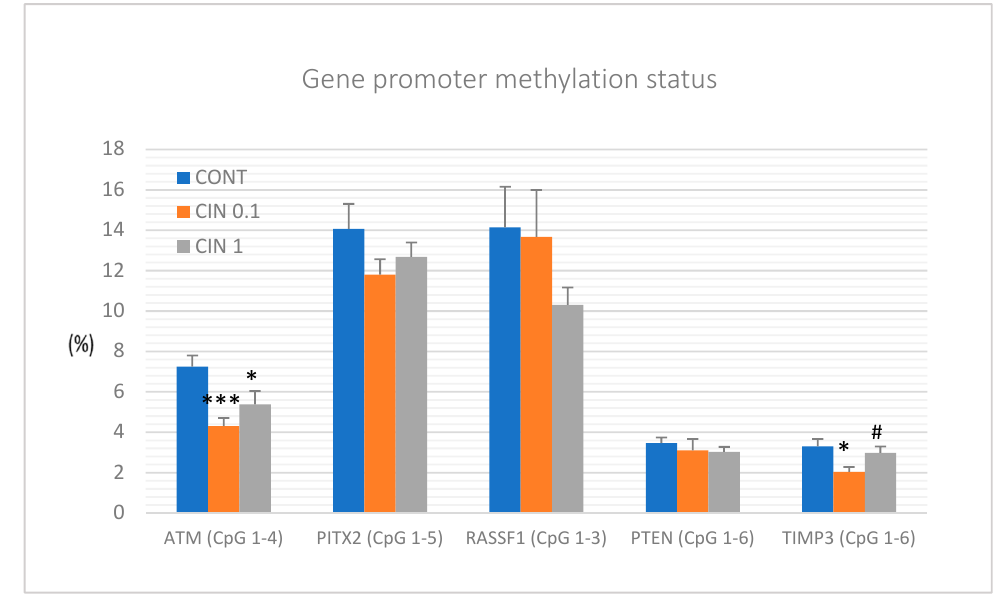
Figure 8. Total DNA gene promoter methylation status of ATM, PITX2, RASSF1A, PTEN, and TIMP3 genes in rat mammary carcinomas. Total promoter methylation status was calculated from all evaluated CpG isles of ATM, PITX2, RASSF1A, PTEN, and TIMP3 in carcinoma tissue from control and treated groups. Significant difference, * p < 0.05, *** p < 0.001 vs. control and # p < 0.05 vs. CIN 0.1.